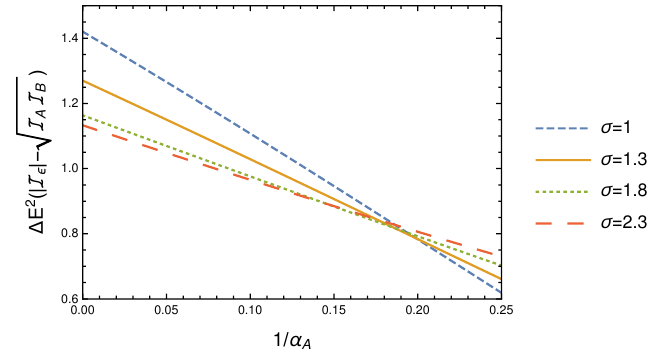
√ (cid:0) (cid:1) is plotted for two anti-parallelly |I ε | − I A I B for different fixed A = 1 . In particular B A